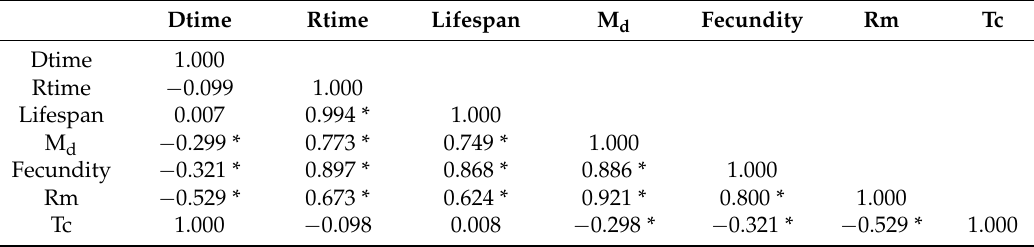
Table 8. Correlation matrix for aphid development time, aphid reproductive time, aphid